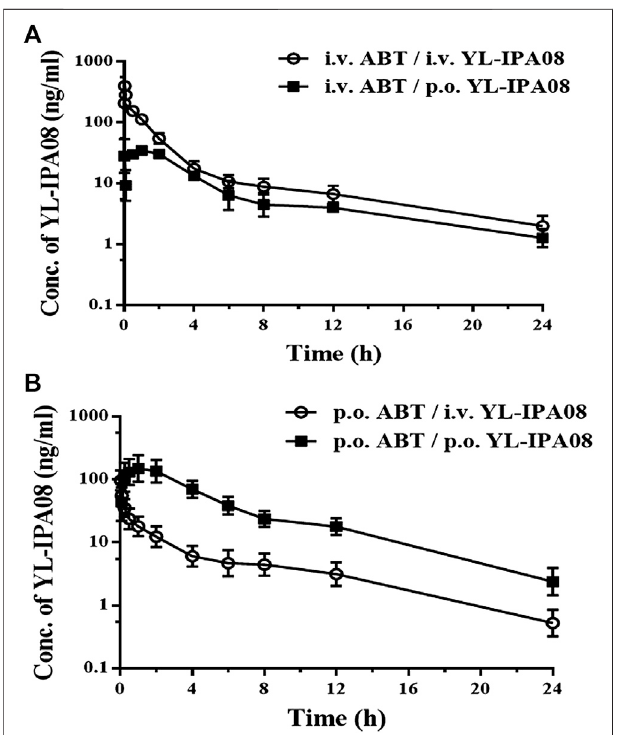
FIGURE 4 | Plasma concentration-time pro fi les of YL-IPA08 after intravenous(0.1 mg/kgor0.5 mg/kg)andoraladministration(1 mg/kg)ofYL- IPA08 combined with ABT pretreatment via intravenous (50 mg/kg) and oral dosing (100 mg/kg) in rats. Error bars represent the standard deviation of the mean concentration (n (cid:2) 6). (A) i.v. 50 mg/kg ABT/i.v. 0.5 mg/kg YL- IPA08 & i.v. 50 mg/kg ABT/p.o. 1 mg/kg YL-IPA08; B: p.o. 100 mg/kg